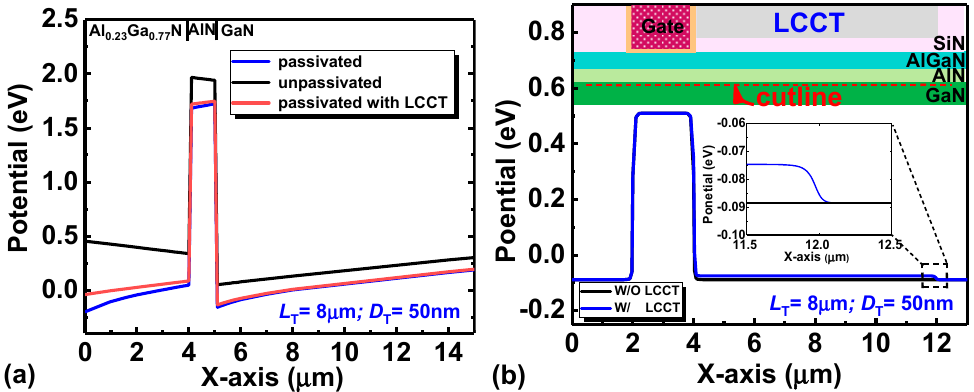
Figure 4. The simulated conduction band structure ( a ) perpendicular to the wafer through the LCCT region and ( b ) along the two-dimensional electron gas (2DEG) channel of conventional HEMT, UTB-HEMT, and LCCT-HEMT.